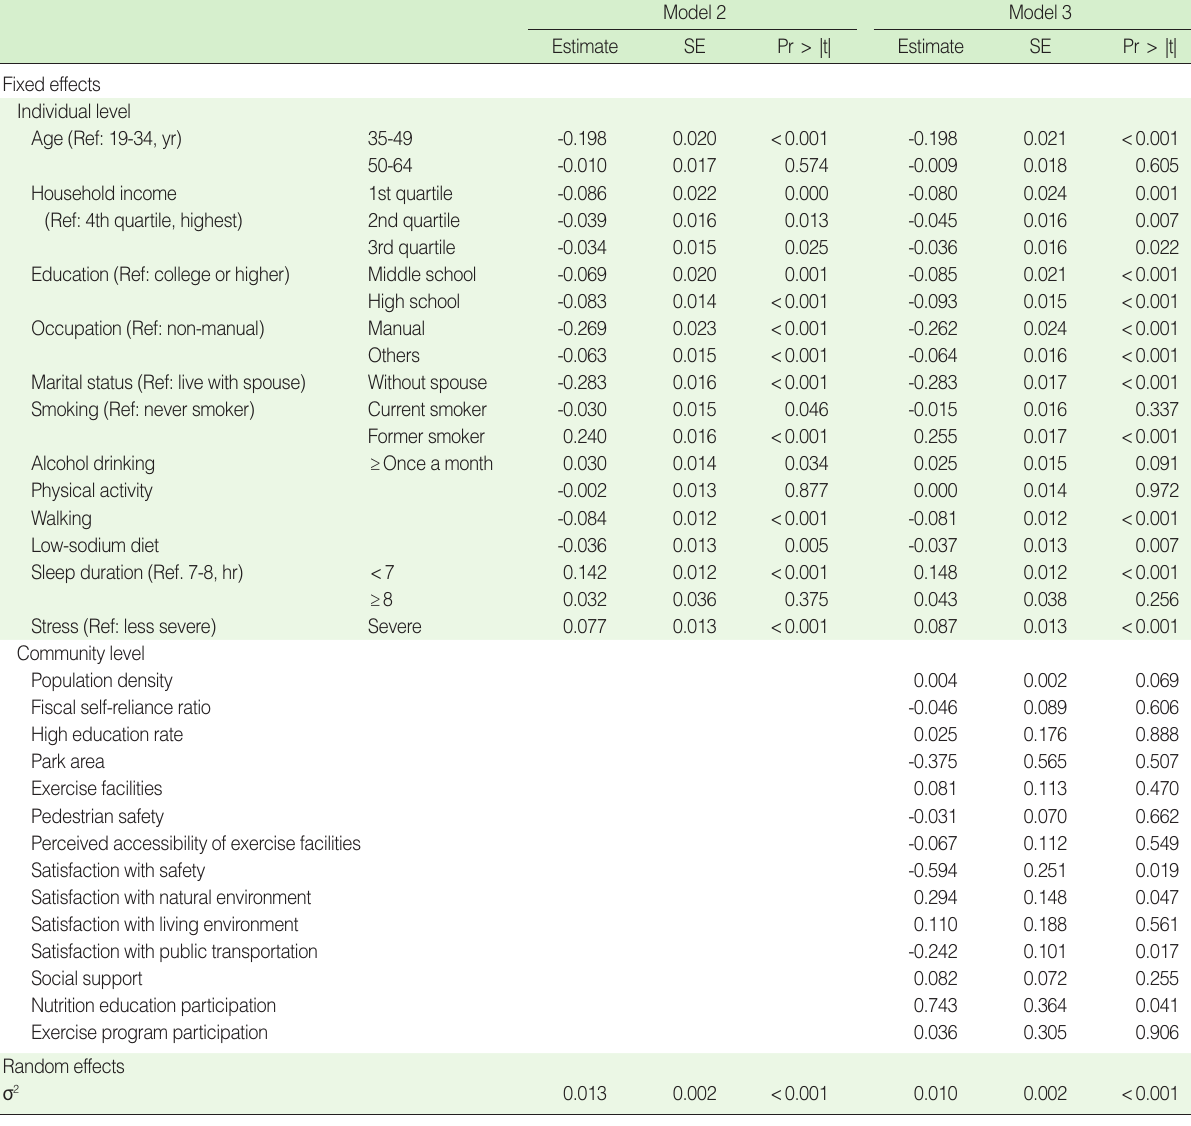
Table 3. Factors affecting obesity among men based on multilevel